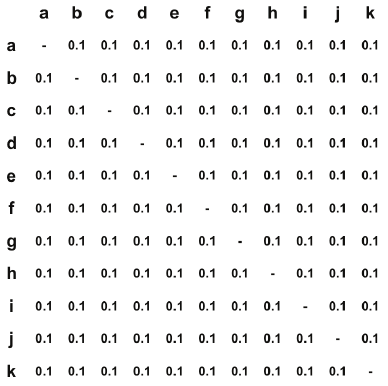
Figure 1. First-order Markov matrix showing probabilities for the eye to transition between stimulus regions a to k based on the assumption that the probabilities are equal